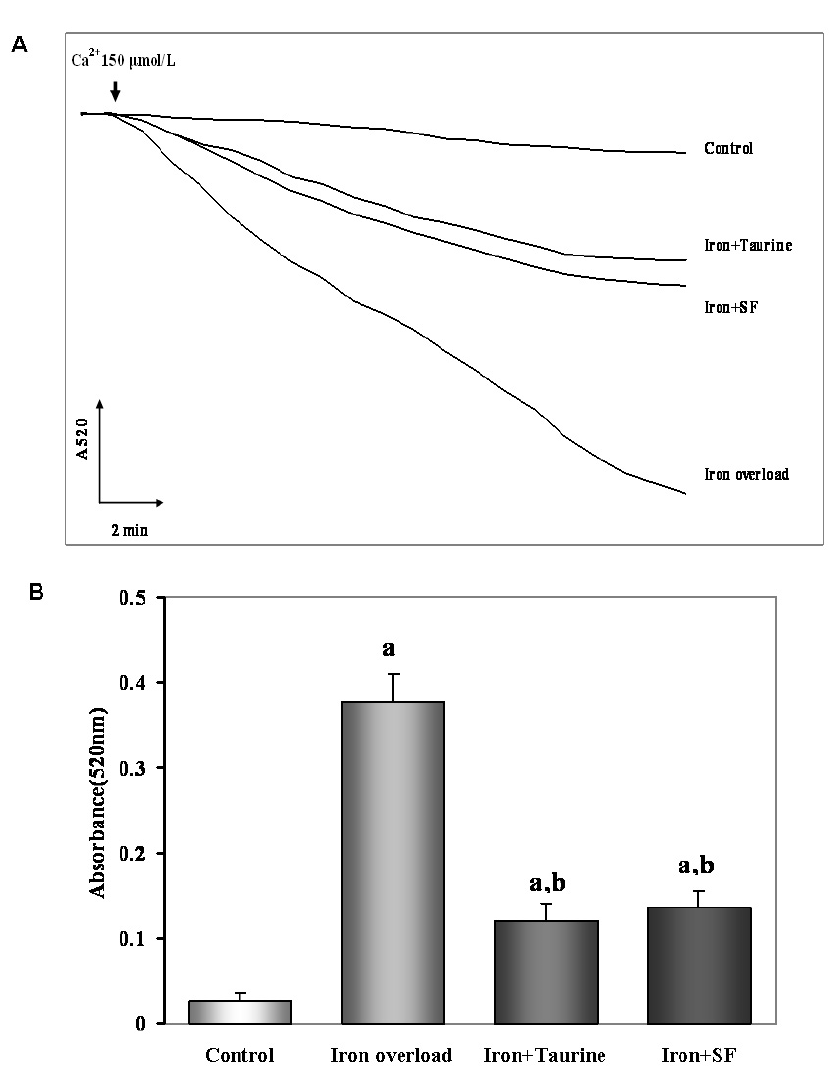
Figure 5. The effect of TAU or SF on hepatocyte mitochondrial swelling in iron-overloaded mic Data represents mean ± SE of 12 independent experiments. ( A ) Ca 2+ -induced mitochondrial swelling in four groups with different treatment. During the onset of mitochondrial swelling, 150 μ M Ca 2+ was added to initiate the reaction. Iron-overload induced mitochondrial swelling, resulted in the large decrease in the absorbance of the mitochondrial suspension at 520 nm in 2 min. However, both SF and TAU inhibited the swelling process; ( B ) Quantitative analysis of mitochondrial swelling. a: p < 0.01, vs. control group; b: p < 0.01, vs. iron overload group.